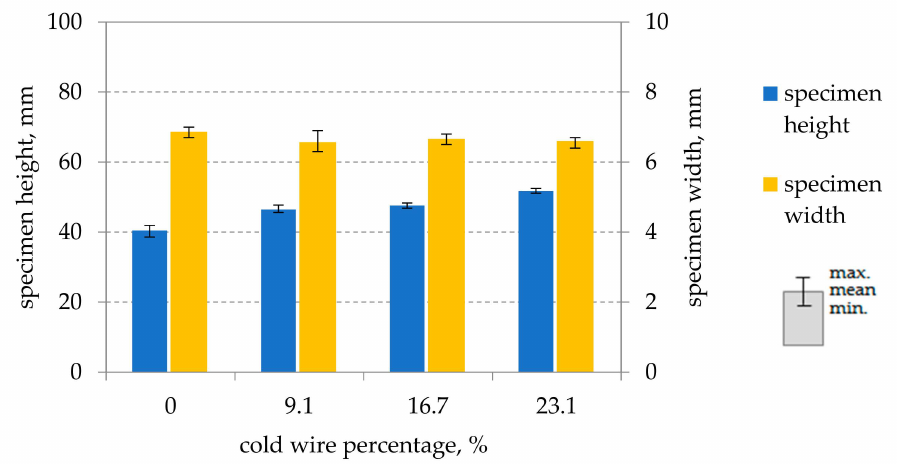
Figure 3. Height and width of the specimens in as-welded condition as a function of the cold wire